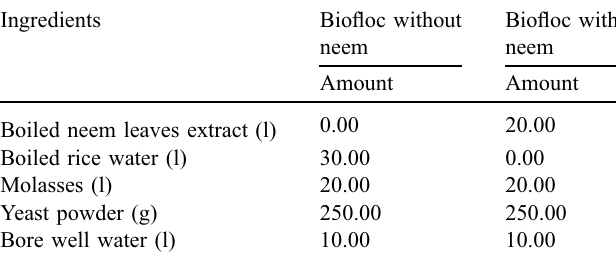
Table 1. Composition of bio fl oc media preparation for use in pond culture of L. vannamei